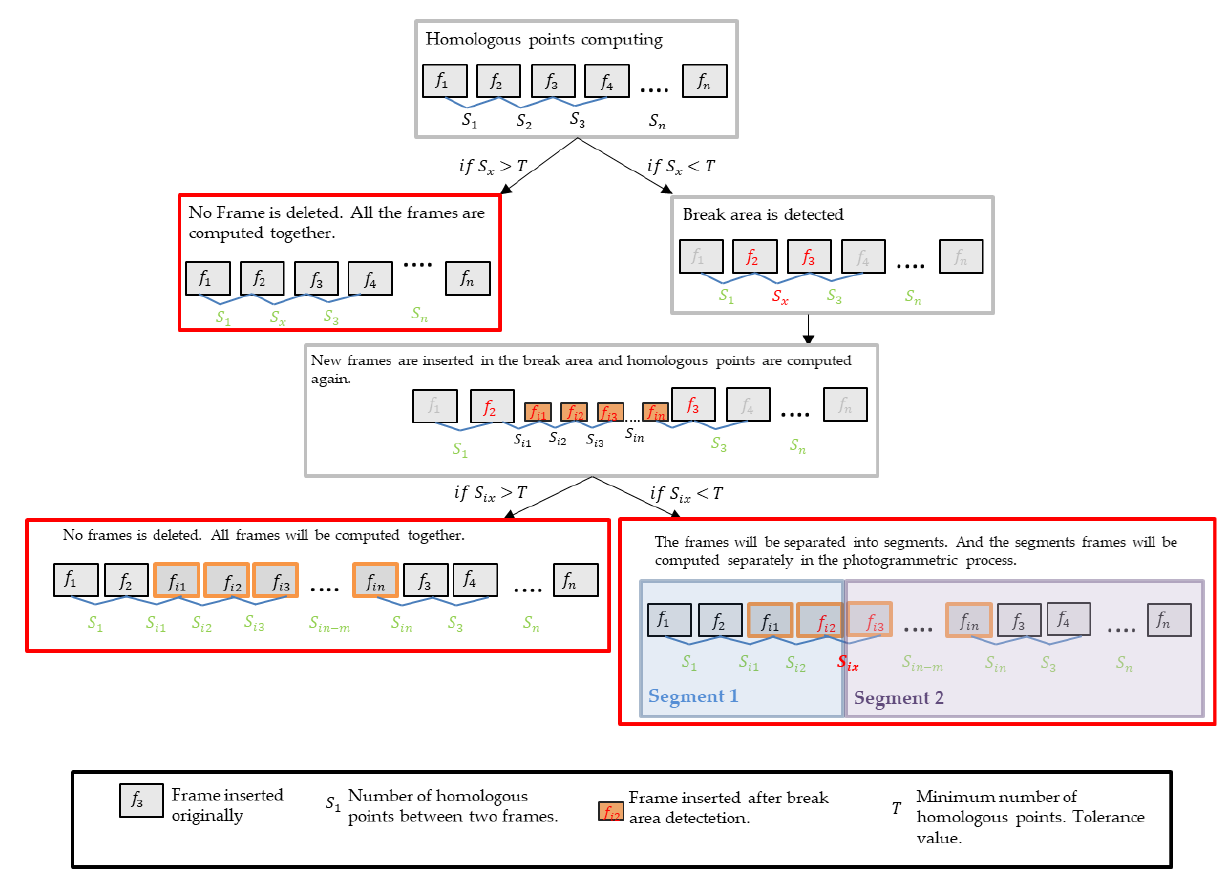
Figure 1 . Key frames selection and filtering algorithm